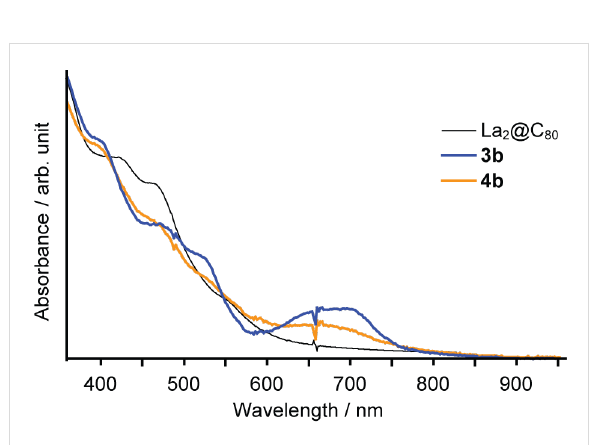
A different approach was taken to purify 3a and 4a because